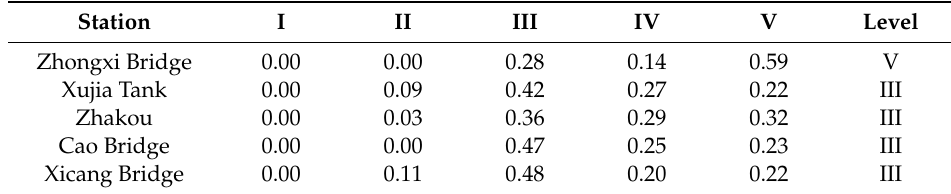
Table 5. Membership degree of the fuzzy comprehensive assessment along the Caoqiao River.